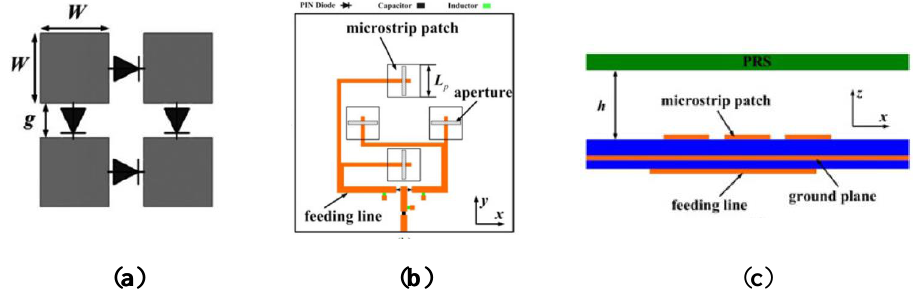
Figure 14. Configuration of a RCA with dual-reconfigurability feature: ( a ) Unit cell; ( b ) Main radiator; ( c ) Entire RCA structure [140].